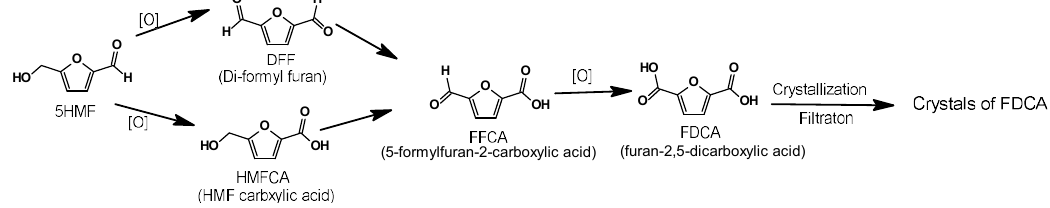
Figure 6. Crystalized separation of 5HMF through oxidation-conversion into FDCA.